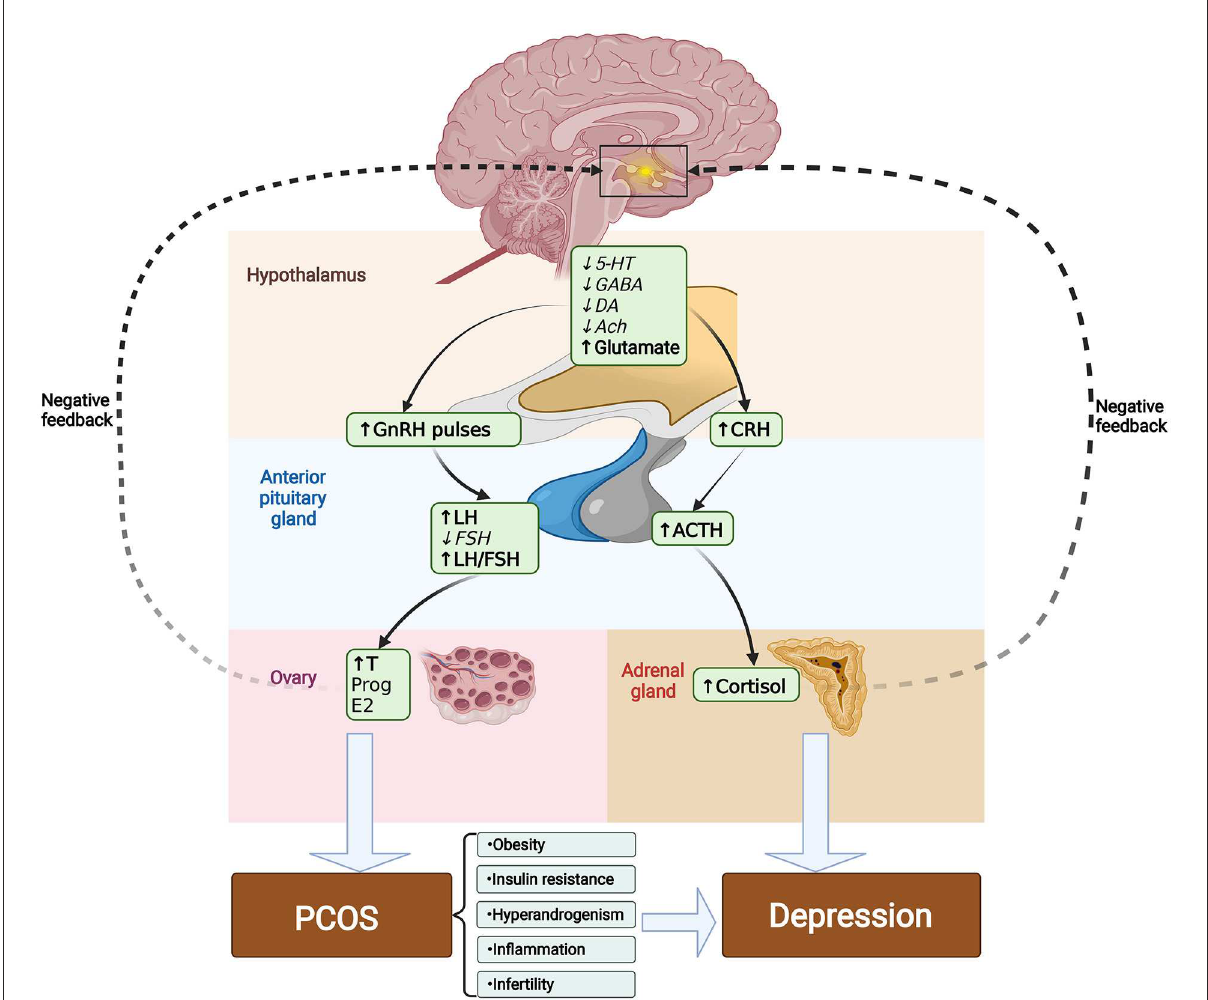
FIGURE1 Changes in neurotransmitters may be involved in the pathogenesis of PCOS-induced depression. In PCOS, GnRH and LH inhibitory neurotransmitters such as 5-HT, DA, GABA and Ach are decreased. While the major stimulants of GnRH and LH such as glutamate are increased. Elevated frequency of release in GnRH encourages LH to be released from the anterior pituitary gland, while reduced frequency encourages the production of FSH, which abnormally increases the LH/FSH ratio. Elevated LH causes theca cells in the ovary to produce excessive androgen and eventually exacerbates the progression of PCOS. Decreased secretion of serotonin, acetylcholine and other neurotransmitters also negatively affects function of the HPA axis, which increases the levels of CRH, ACTH, and cortisol, causing continuous hyperactivity of the HPA axis, and leading to depression. Meanwhile, the pathological traits of PCOS, including obesity, insulin resistance, hyperandrogenism, inflammation, and infertility can exacerbate the onset of depression. Italic font indicates lower levels compared to normal, whereas bold font indicates higher levels. 5-HT, serotonin; DA, dopamine; GABA, gamma-aminobutyric acid; Ach, acetylcholine; GnRH, gonadotropin-releasing hormone; LH, luteinizing hormone; FSH, follicle stimulating hormone; T, Testosterone; E2, estradiol; CRH, corticotropin releasing hormone; ACTH,